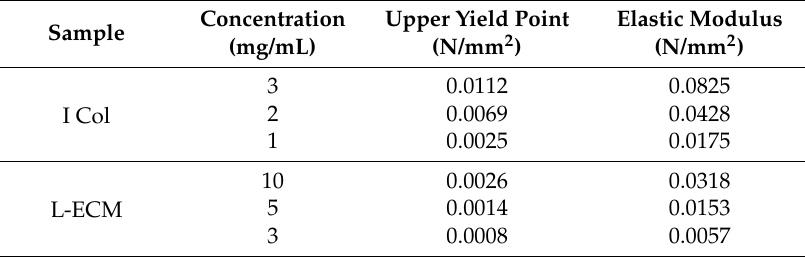
Table 1. Upper yield point and elastic modulus of I Col and L-ECM